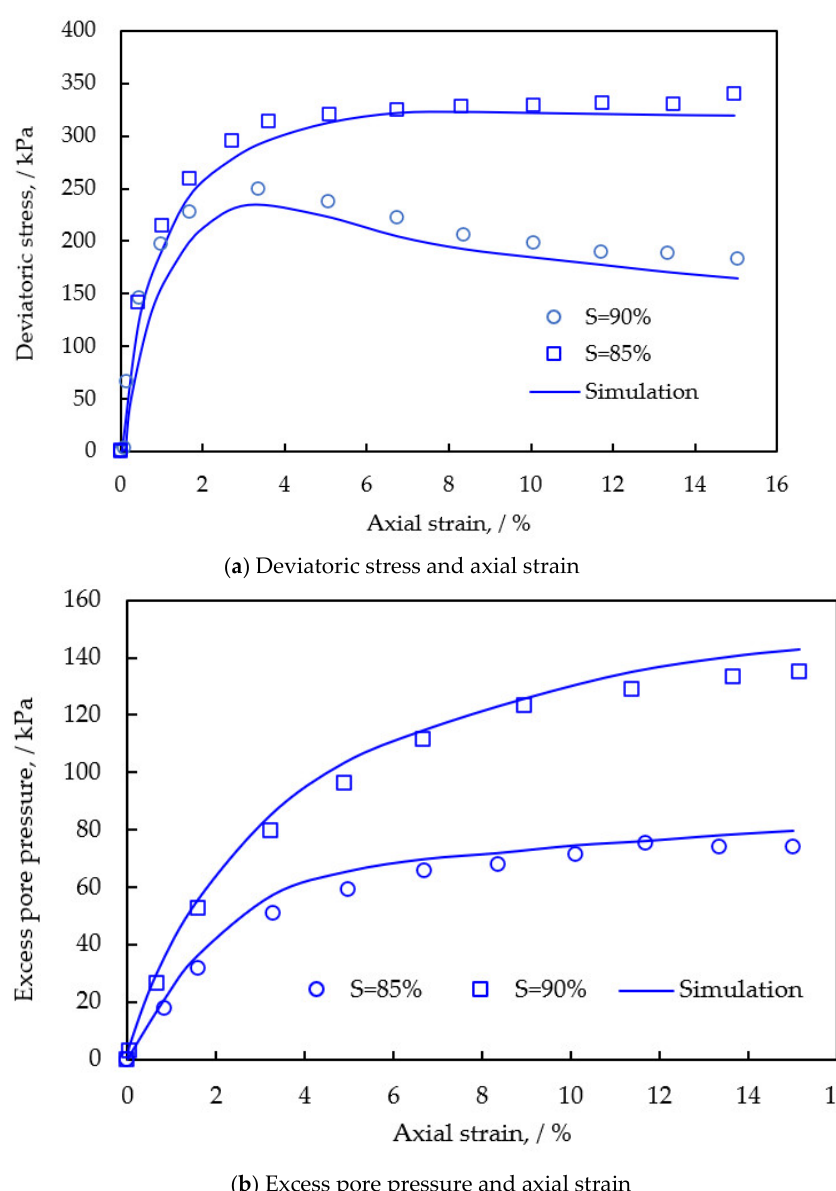
Figure 5. Undrained triaxial compression test results and model simulations for gassy sand ( e 0 = 1.09, p c = 200 kPa).